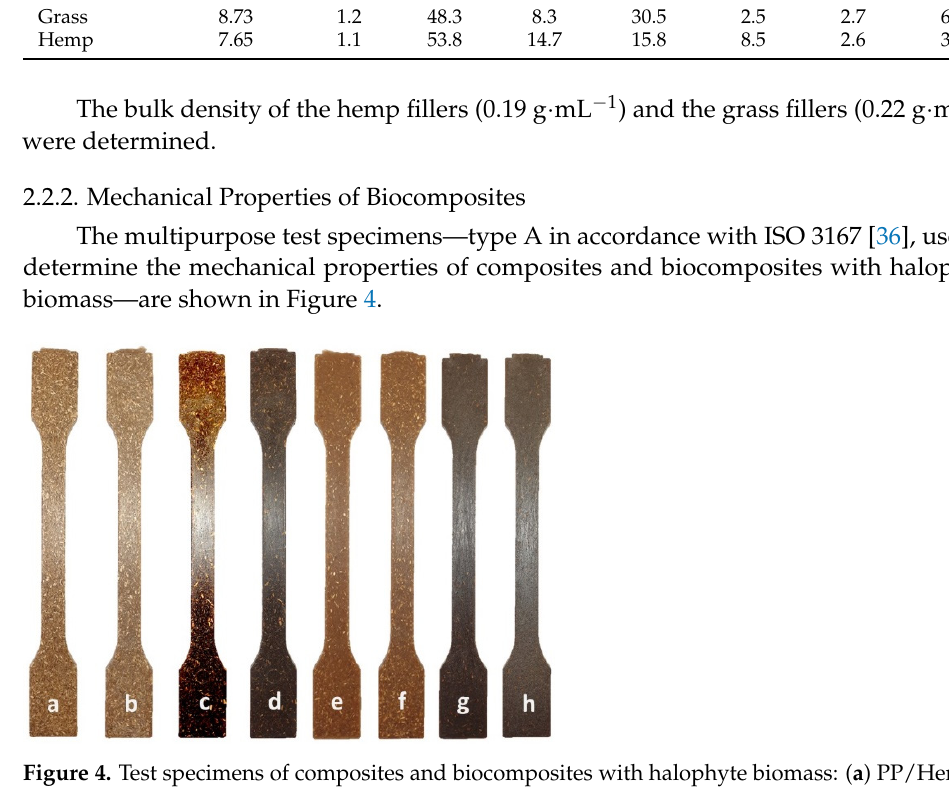
Table 5. Tensile and flexular properties of PP/hemp composites.